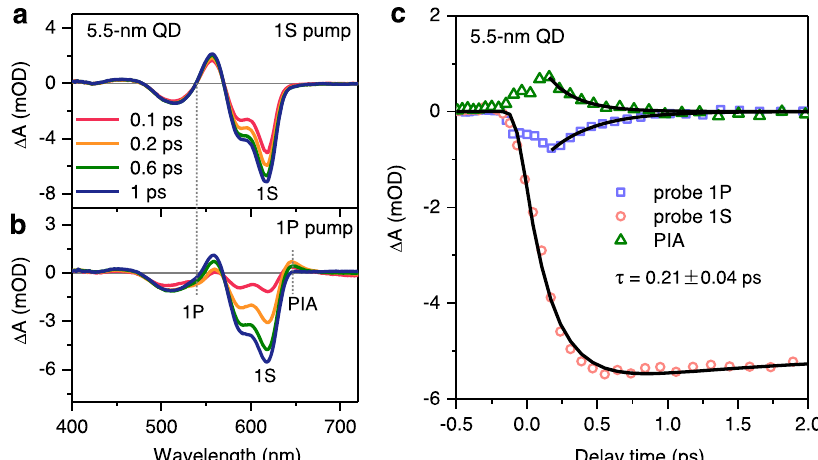
Fig. 3 Hot electron dynamics in neutral QDs. Transient absorption (TA) spectra of neutral CdSe QDs probed at indicated time delays following excitations at a 1S e -1S 3/2,h and b 1P e -1P 3/2,h transitions by 624 and 547 nm pulses, respectively. The 1S bleach, 1P bleach and PIA features are indicated in b . c TA kinetics probed at the 1S bleach (~617 nm; red circle), 1P bleach (~544 nm; blue square) and PIA (~646nm; green triangle) features in the case of 1P e -1P 3/2,h excitation. Black solid lines are simultaneous fi ts to a single-exponential relaxation time constant of 0.21 ps.